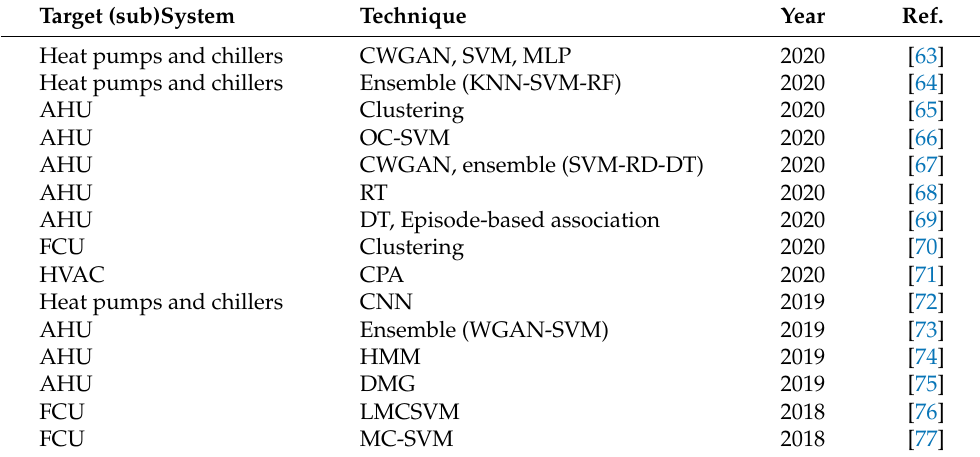
Table 3. Cont. Target (sub)System Technique Year